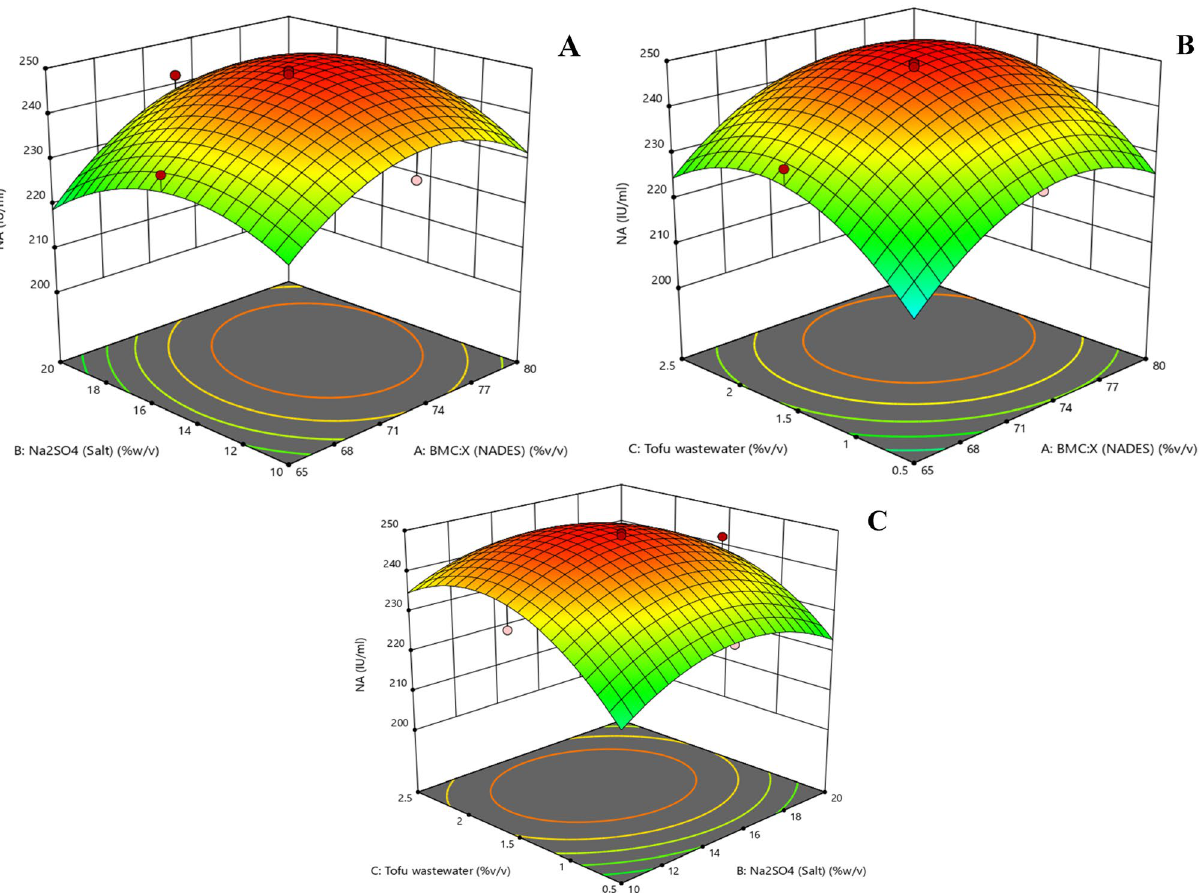
Figure 3. Response surface plot showing the cumulative effect of concentration of ( A ) Na 2 SO 4 with NADES ( B ) soy milk with NADES and ( C ) soy milk with Na 2 SO 4 on extractive fermentation of